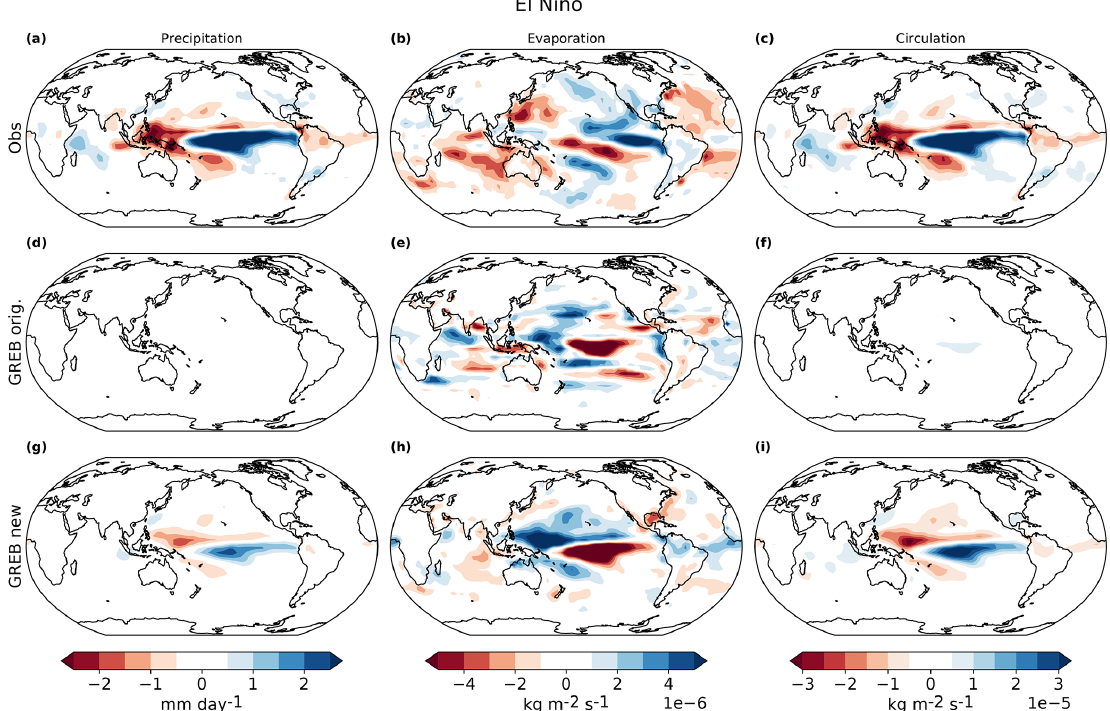
Figure 10. The El Niño response of the hydrological cycle in observations for precipitation (a) in mmday − 1 , evaporation (b) and circu- lation (c) in kgm − 2 s − 1 , original GREB model for precipitation (d) , evaporation (e) and circulation (f) and the improved GREB model for precipitation (g) , evaporation (h) and circulation (i) . GREB uses prescribed anomalies from an El Niño composite mean of surface temperature, horizontal winds and vertical winds ( ω